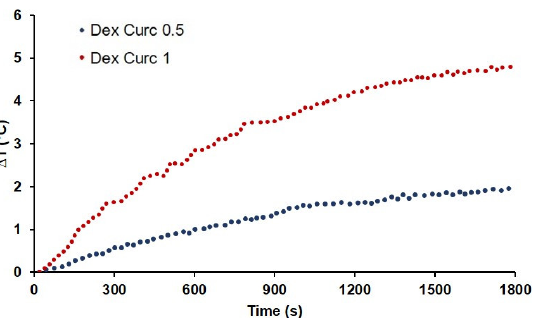
Figure 11. Magnetic hyperthermia measurements under an alternating (f = 429 kHz) magnetic field of 300 Oe for 30 min: temperature increase as a function of time of the curcumin-loaded dextran MOLNBs at different concentrations of SPIONs (1 mg/mL and 0.5 mg/mL).